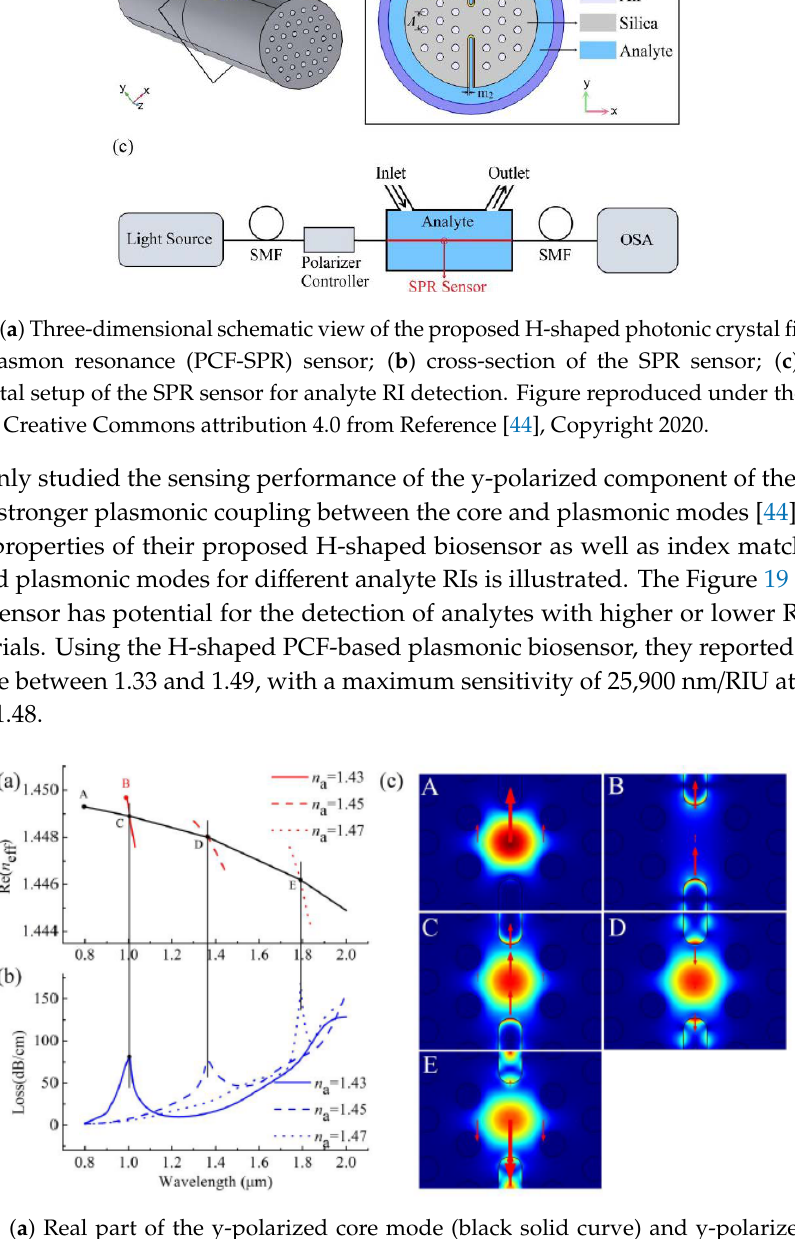
15 of 23 Figure 17. Cross section of PCF-based plasmonic biosensors based on a ( a ) trapezoidal-channel, ( b ) semi-circular channels, ( c ) H-shaped geometry with air holes, and ( d ) H-shaped microstructured geometry. H-shaped PCFs is another fiber geometry that demonstrated potential for designing highly accurate and ultra-sensitive plasmonic biosensors [44]. The cross-sectional view of plasmonic H- shaped PCF biosensors are demonstrated in Figure 17c. As seen in Figures 17 and 18, the H-shaped geometry consists of a solid (or hollow) core encircled with an array of airholes and two grooves alongside of the core of PCF. The grooves are usually filled with analyte, which is in direct contact with plasmonic nanofilms/nanoparticles. In 2020, Han et al. [44] theoretically and numerically reported a new design of H-shaped PCF- based SPR sensor for detecting analytes with a large detection range. The possible experimental setup, three-dimensional diagram of the sensor and the cross-sectional view of the fiber probe is illustrated in Figure 18. According to Figure 18, the grooves of their proposed H-shaped PCF as the